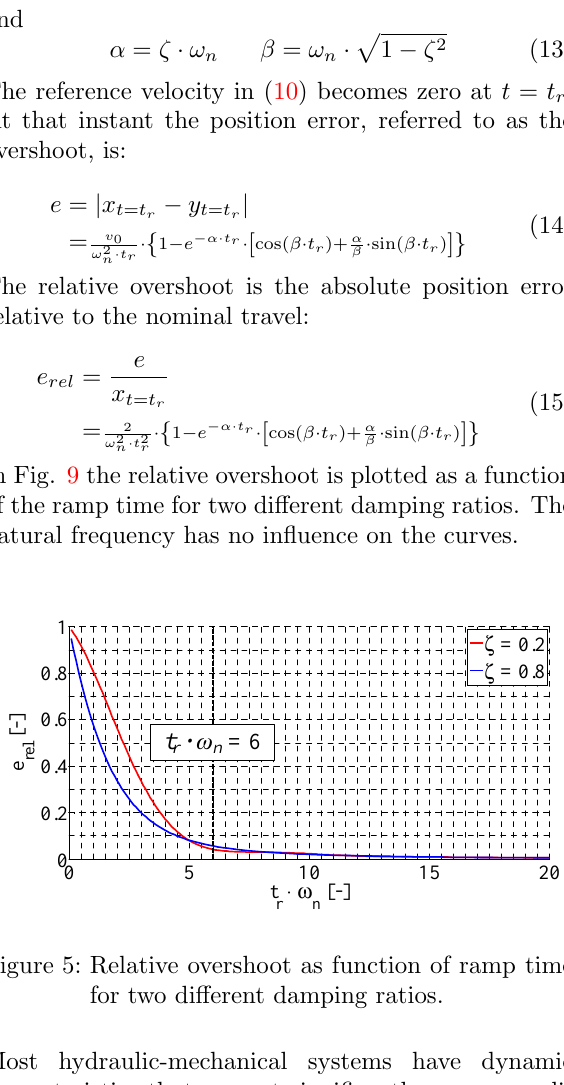
Figure 4: Second order system with a mass travelling at a speed ˙ y = v 0 .